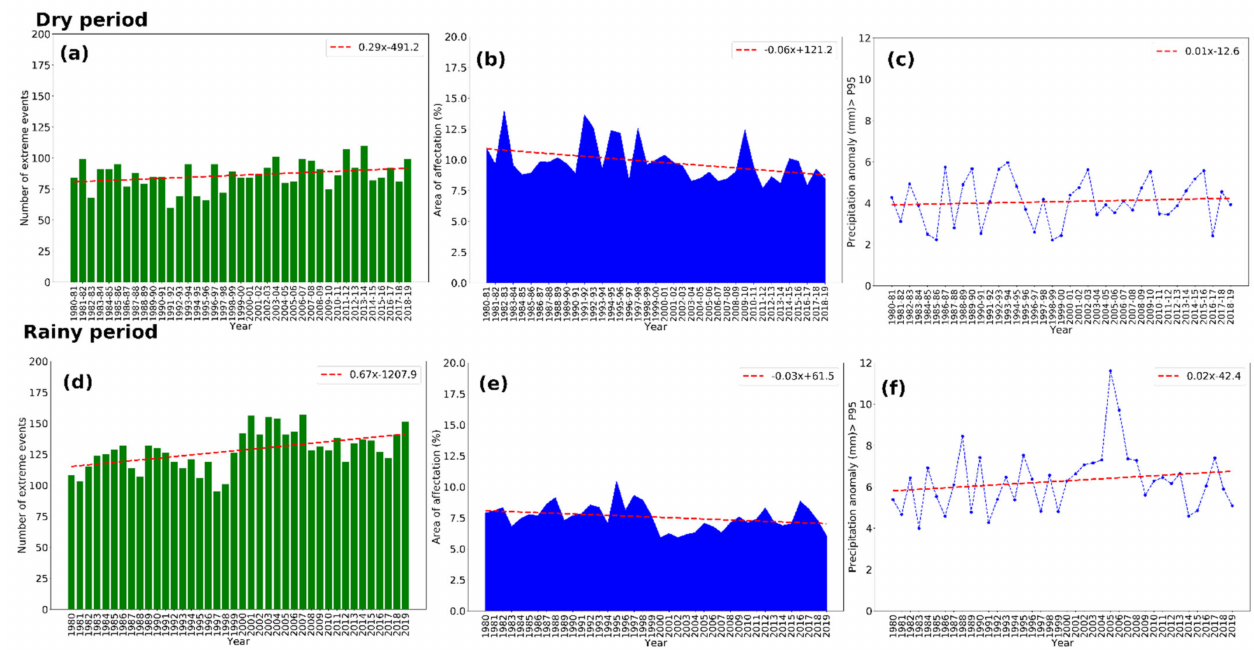
Figure 5. Number of extreme precipitation events ( a , d ). Area affected by extreme precipitation events expressed as percentage respect the total area of Cuba ( b , e ) Precipitation anomaly of >P95 ( c , f ). The dashed red line represents the linear trend. The upper and lower row corresponds to the dry and rainy periods, respectively. Period